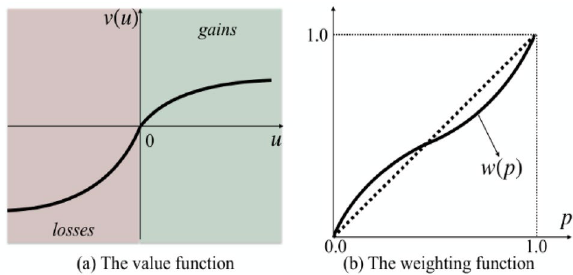
Figure 5. Examples of the value function and weighting